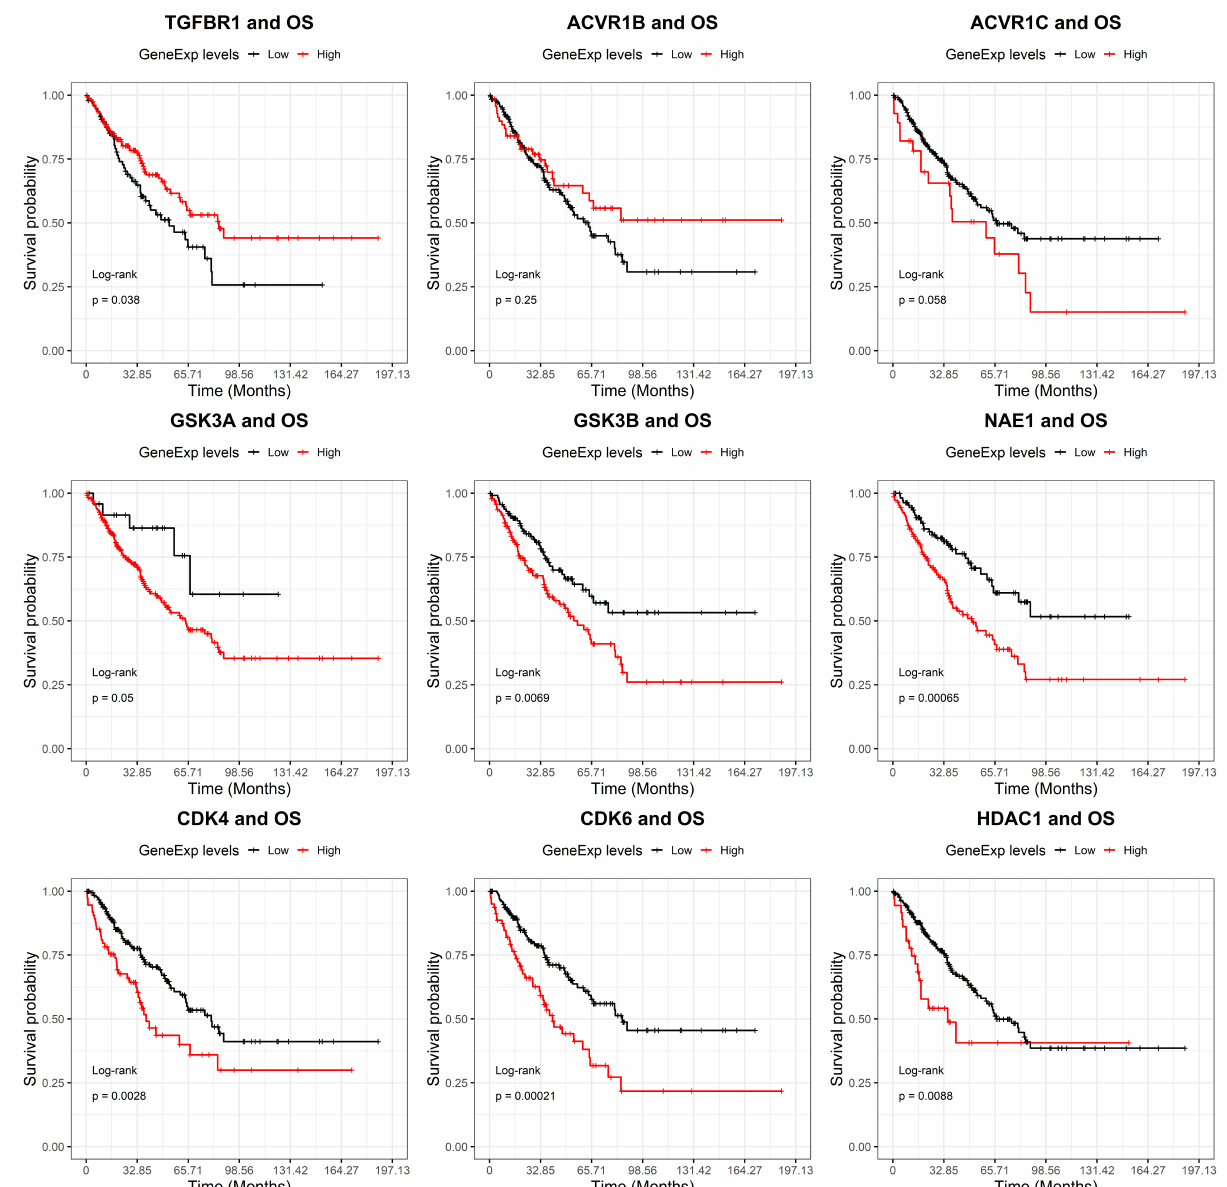
Figure 1. Overall survival (OS) curves, based on mRNA expression levels of the nine drug targets’ genes in the TCGA Sarcoma dataset. High (red) and low (black) expression cohorts were divided through maximally selected rank statistics. The significance of survival differences was estimated by log-rank tests. Number of patients: TGFBR1: low 98, high 161; ACVR1B: low 189, high 70; ACVR1C: low 231, high 28; GSK3A: low 25, high 234; GSK3B: low 117, high 142; NAE1: low 112, high 147; CDK4: low 185, high 74; CDK6: low 179, high 80; HDAC1: low 223, high